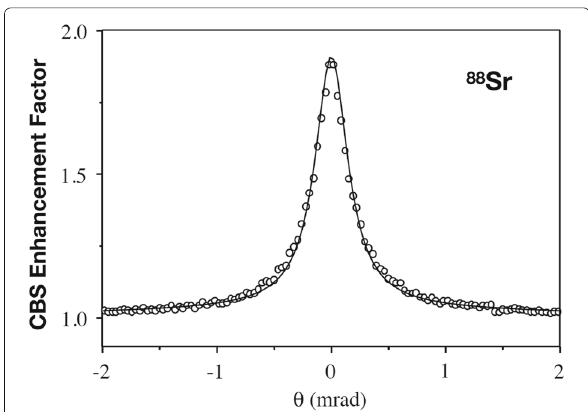
Fig. 2 CBS signal obtained with a laser-cooled atomic cloud of Strontium atoms ( 88 Sr) in the helicity-preserving channel, see [39]. Since this atom has no spin in its ground state, the reciprocity relation Eq. (85) implies that, at exact backscattering, the two CBS amplitudes interfere with equal weight in this polarization channel. Furthermore, having no structure in its ground state, this atom is spherically-symmetric and the single scattering signal is also filtered out. As a consequence, and up to some experimental imperfections, one measures the so-called “factor 2” for the CBS contrast